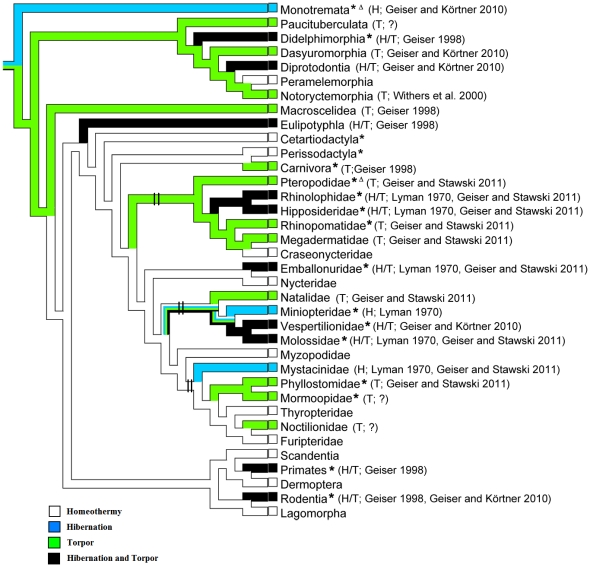
Reconstruction of ancestral states.Multistate data of homeothermic and heterothermic (hibernation and/or torpor) states are mapped onto the composite species tree (Teeling et al. 2005 and Nishihara, Hasegawa, and Okada 2006). Branches show the species of family are homeothermic (white), hibernators (blue), torpor (green), or hibernators and torpor (black). *: some species of this family were test in this study; Δ: species studied here are homeothermic. ?: some species of this family are likely heterothermic. Vertical bars on branches represent the lineages which are potentially related with the evolution of bat heterothermy.